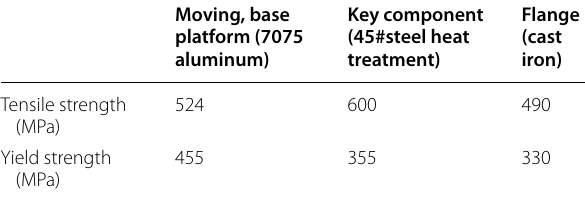
Table 2 Properties of materials in key